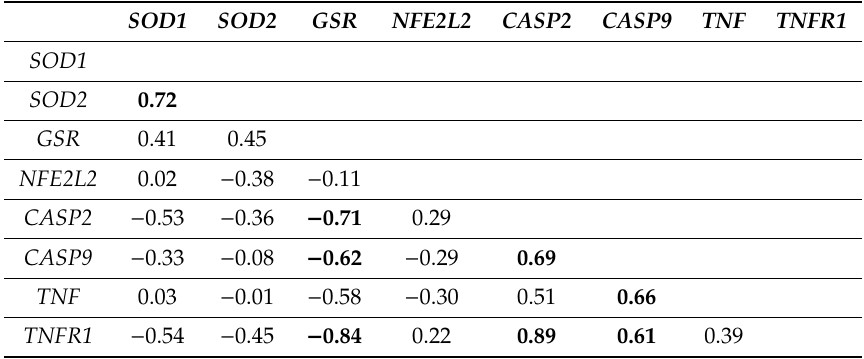
All values in bold are significant p < 0.05.